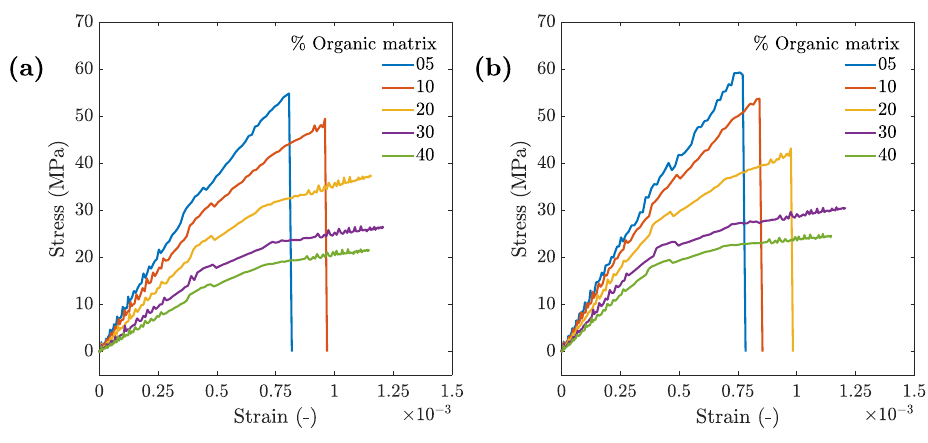
Figure 6. Stress–strain response of nacre-like composites for varying organic volume percentage. The considered elastic modulus of organic matrix are: ( a ) E o = 3.78 GPa; and ( b ) E o = 11